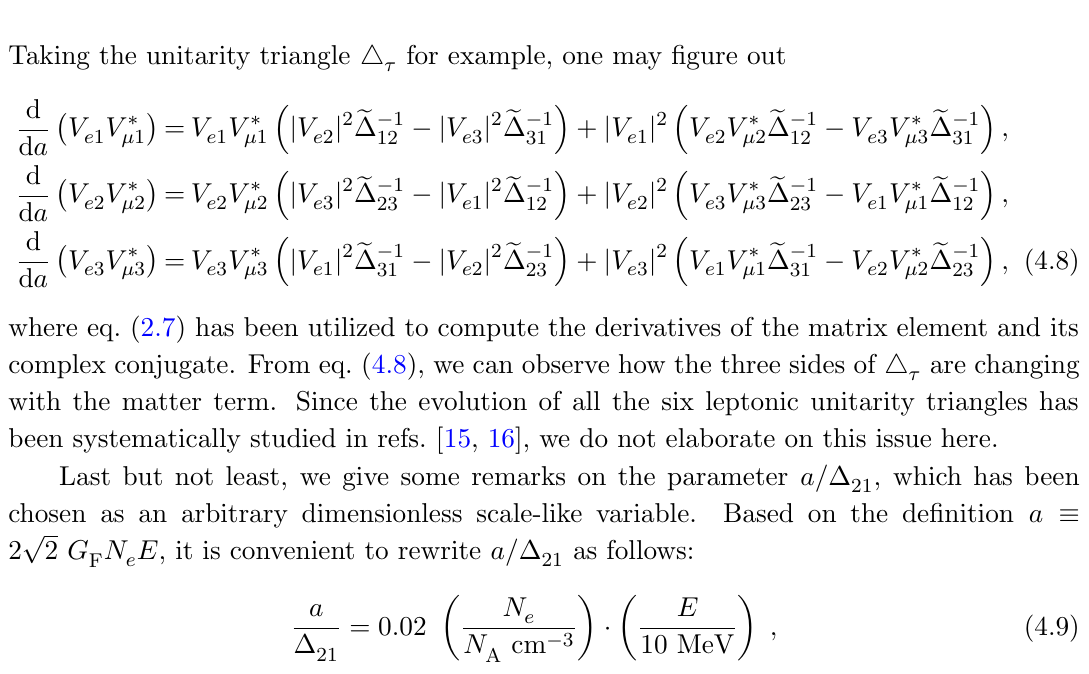
= cm 3 ) [39], solar neutrinos at A = cm 3 ) A